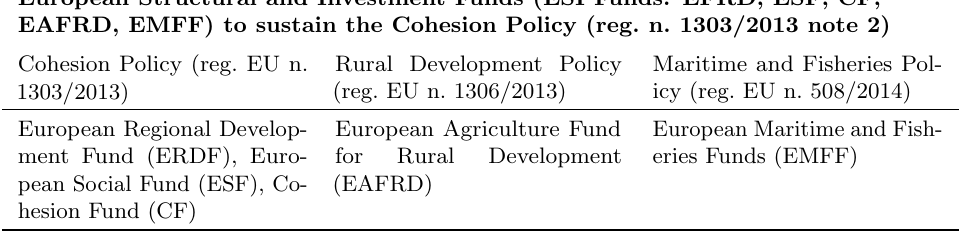
pean Social Fund (ESF),